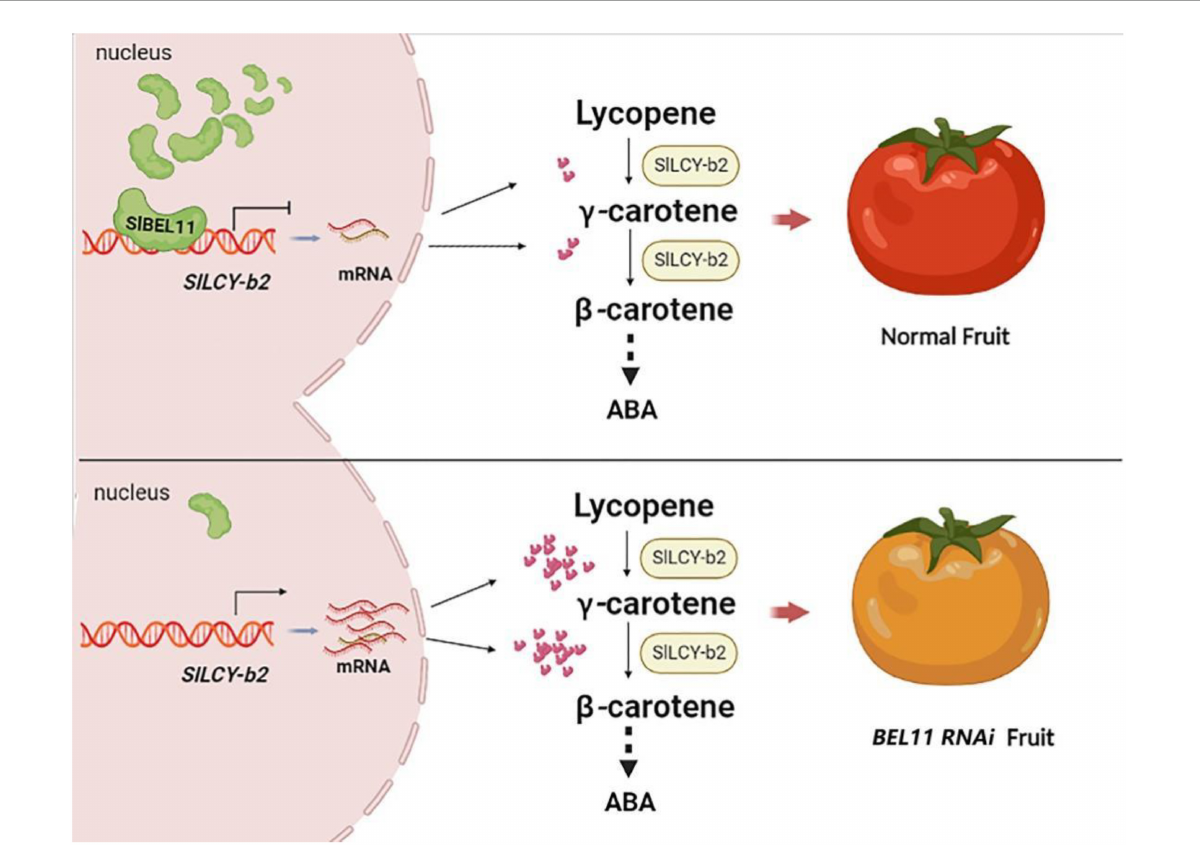
FIGURE6 Working principle of the role of SlBEL11 for carotenoid biosynthesis in tomato fruit. SlBEL11 was a transcription factor that acted directly on the promoter of SlLCY-b2 and suppressed its transcription. When SlBEL11 was silenced, the gene encoding the SlLCY-b2 enzyme that catalyzed lycopene was upregulated, resulting in increased downstream carotenoid accumulation. Ultimately, SlBEL11 RNAi tomatoes yielded yellow fruits instead of red ones because of abnormal carotenoid